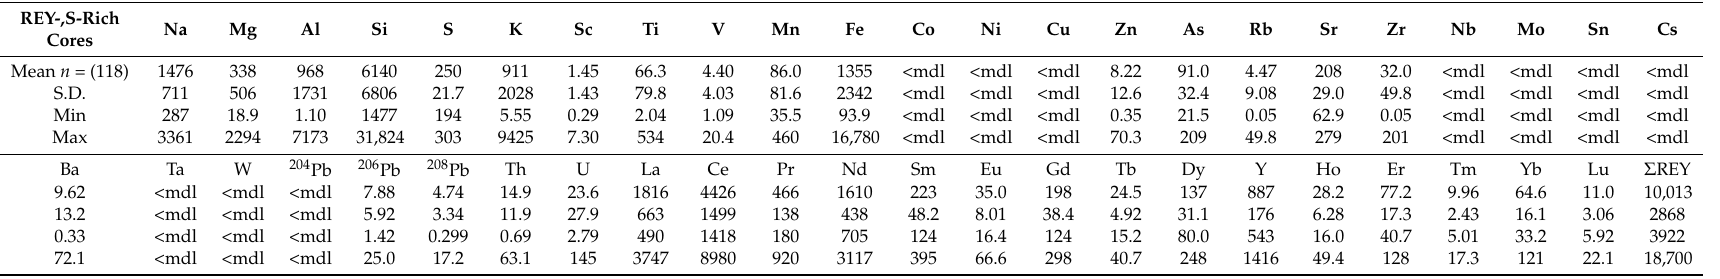
Table 6. REE and trace element concentrations in apatite from the Distal Satellite (ppm). Apatite analyses were performed on multiple grains in the following